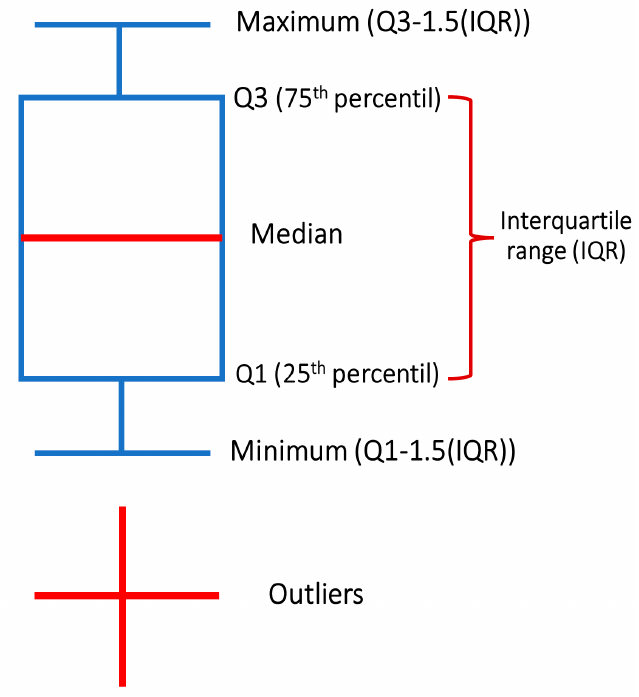
Figure 10. Box and whisker symbology.